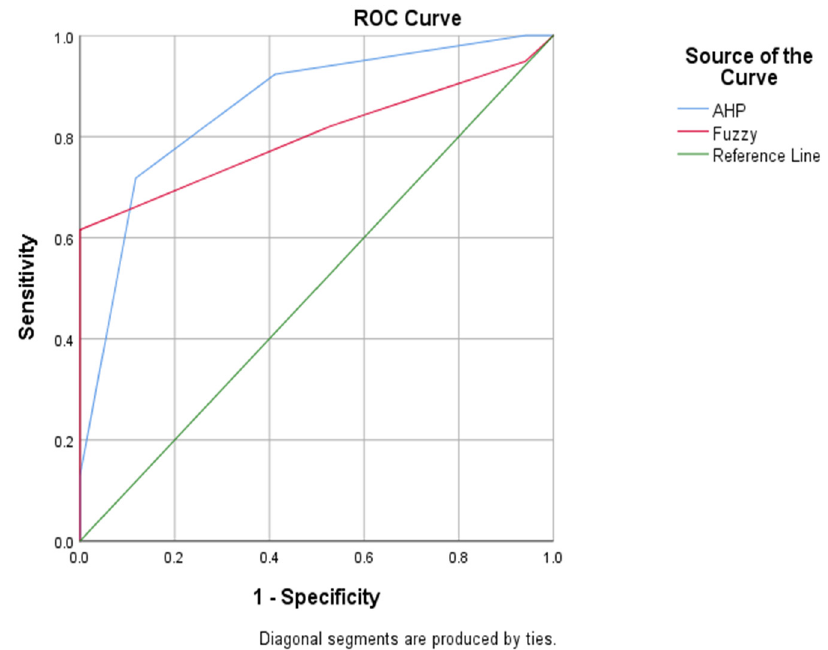
Figure 6. ROC for validation of AHP and fuzzy models.